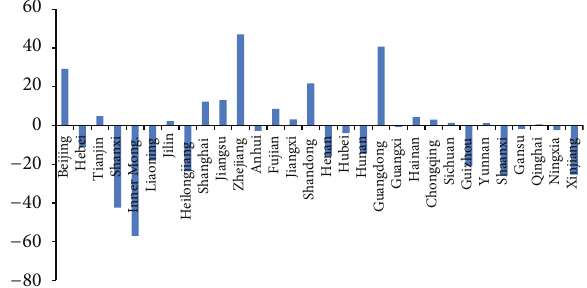
Figure 2: Unit inflow of embodied energy via interprovincial trade for each province in 2007 (in tons of standard coal/10,000 RMB).